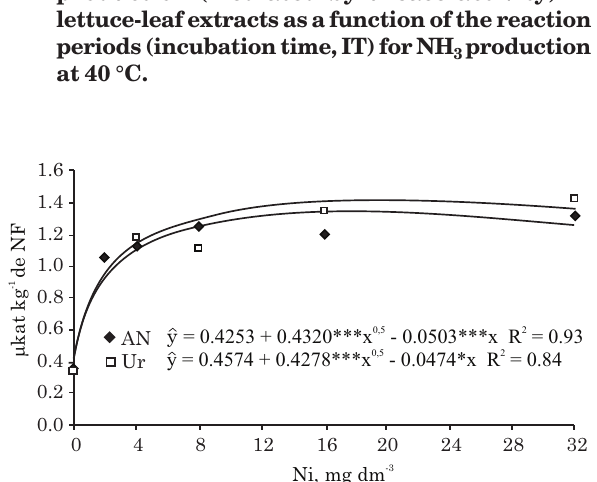
Figure 3. Urease activity in the fresh matter (FM) of lettuce leaves as a function of Ni doses added to soil fertilized with N supplied as ammonium nitrate (AN) and urea